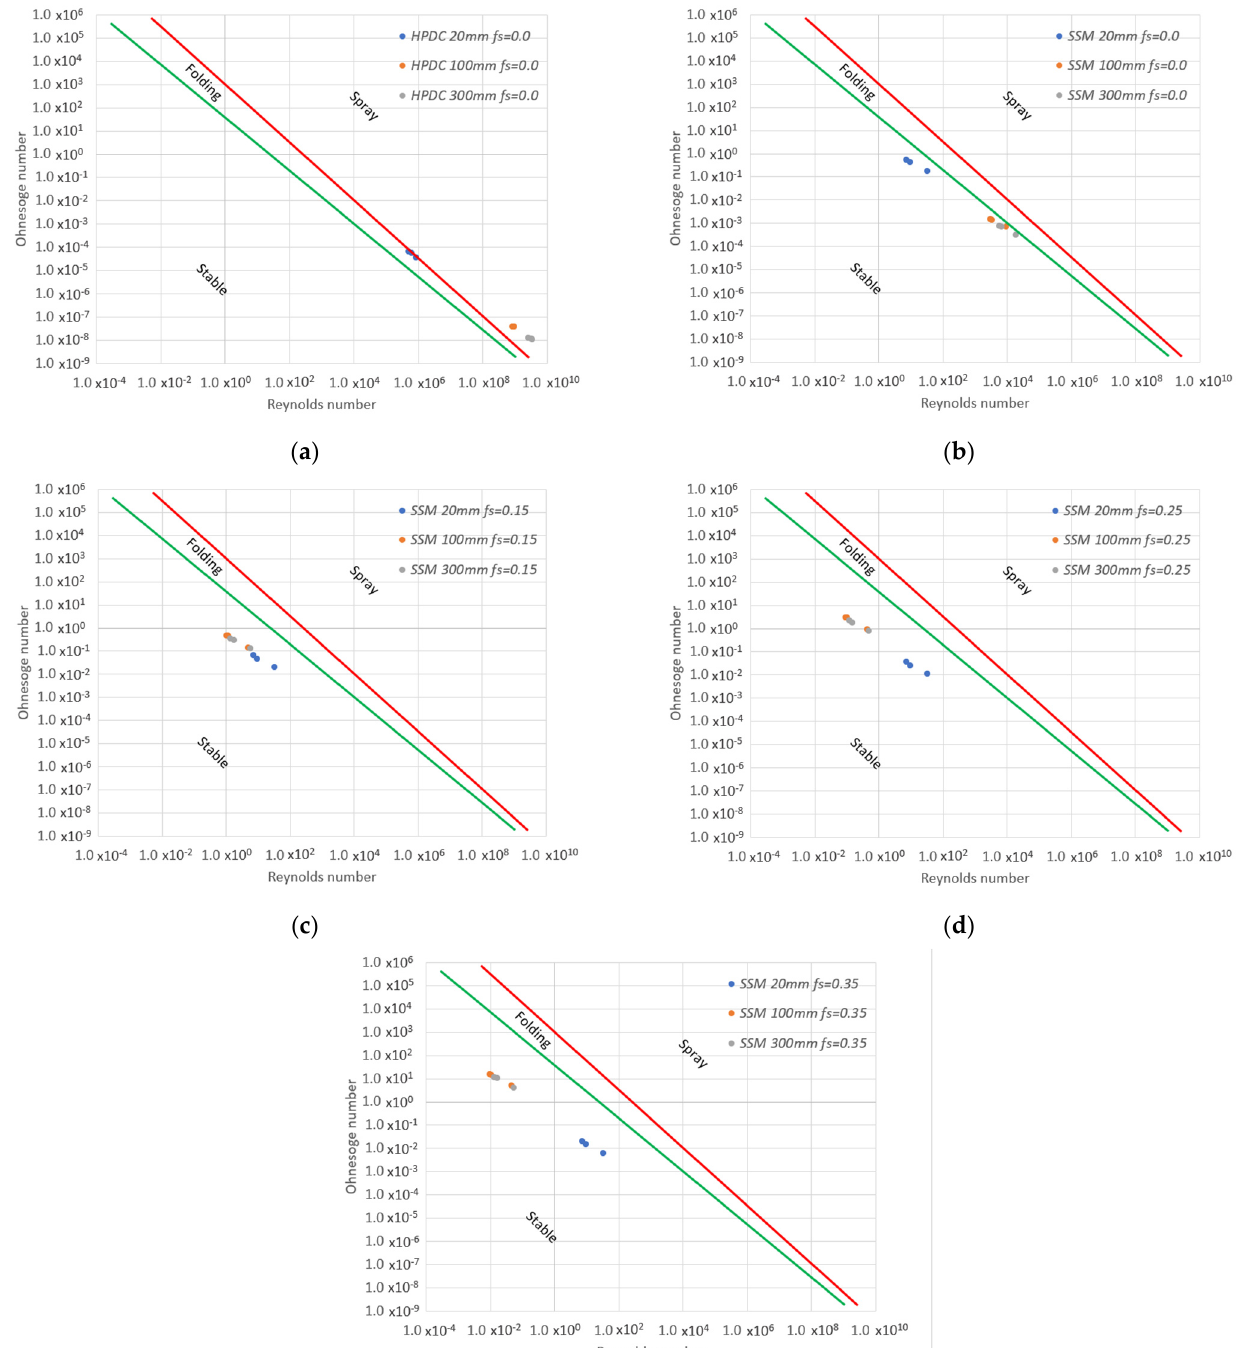
Figure 2. Break-up analysis with the Ohnesorges number plotted against the Reynolds number for ( a ) HPDC conditions without solid content; ( b ) SSM conditions without any solid fraction; ( c ) SSM conditions with f s = 0.15 where practical stability based on We was found; ( d ) SSM conditions with f s = 0.25 where absolute stability based on We was found; ( e ) SSM conditions with f s = 0.35, a typical fraction used in high fraction SSM processing. The green line is first wind break-up, and the red line is second wind break-up. Blue markers are 20 mm gate width, orange markers are 100 mm gate width and grey is for 300 mm gate widths.